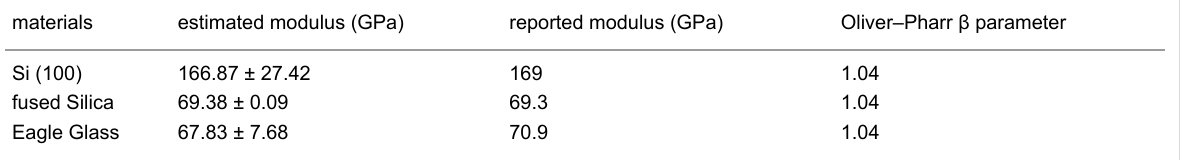
Table 3: Estimation of elastic modulus by Oliver–Pharr fitting and the parameters used.